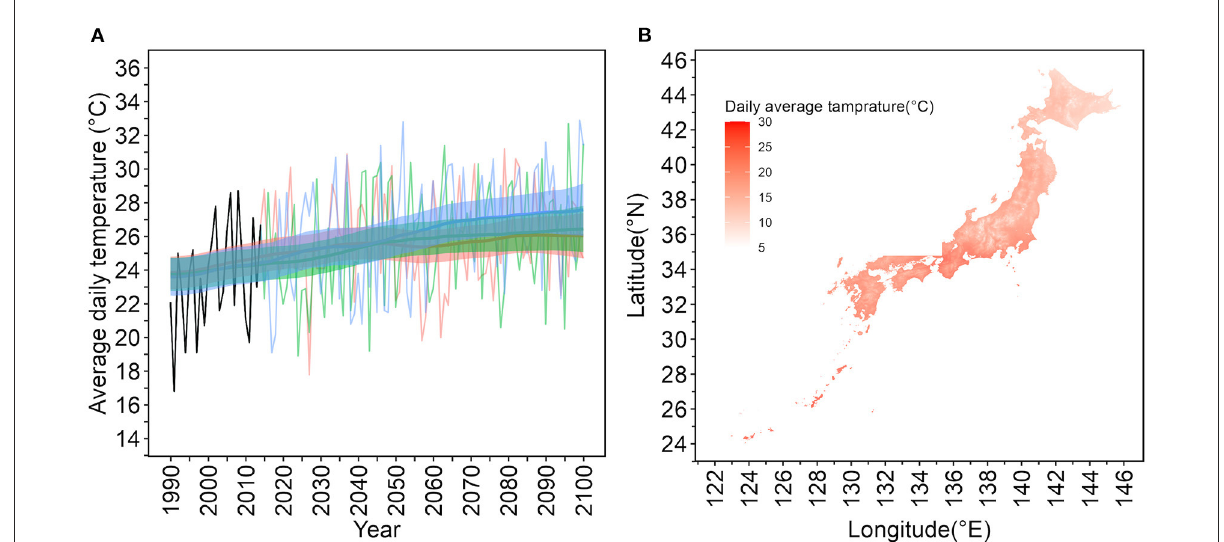
FIGURE1 Daily average temperatures on July 1 from 1990 to 2100 in Tokyo based on the Model for Interdisciplinary Research on Climate version 6 (MIROC6) and a geographic snapshot of daily average temperatures in Japan. (A) Temporal distribution of daily average temperatures on July 1 in the specific mesh containing 35.6716 ◦ N, 139.6967 ◦ E, where Yoyogi Park in Tokyo is located. The years from 1990 to 2015 are historical data and reconstructed estimates based on observations. The MIROC6 was used to predict the period from 2016 to 2100. The oscillating lines are the model predictions. Thick lines are expected values estimated using Kalman filtering and smoothing. The shaded upper and lower lines are 95% confidence intervals of the expected values. Red lines represent the representative concentration pathway (RCP) 2.6 scenario, green the RCP4.5 scenario, and blue the RCP8.5 scenario. (B) Geographic snapshot of the average temperature on July 1, 2030 in Japan. The darker the red color, the higher the temperature. Japan is in the northern hemisphere, and temperatures are lower in the north. The snapshot shown is for July 1, during the summer season; however, even on the same day, there is a temperature difference of more than 20 ◦ C within Japan.